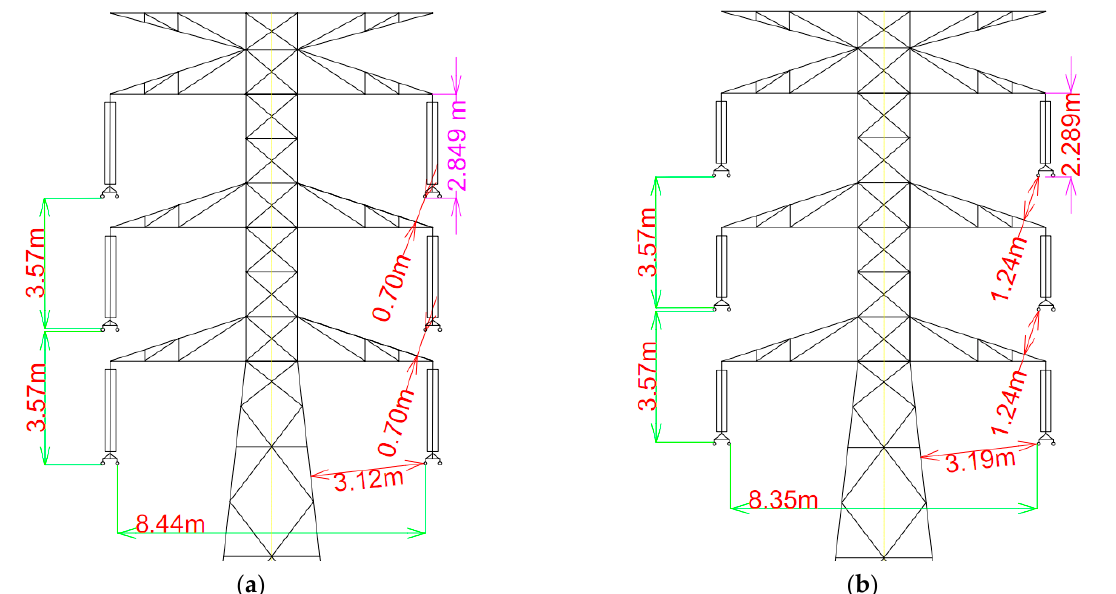
Figure 4. The 132 kV steel lattice tower geometry; ( a ) with 275 kV glass discs insulator, and ( b ) adjusting insulator length and its creepage distance.